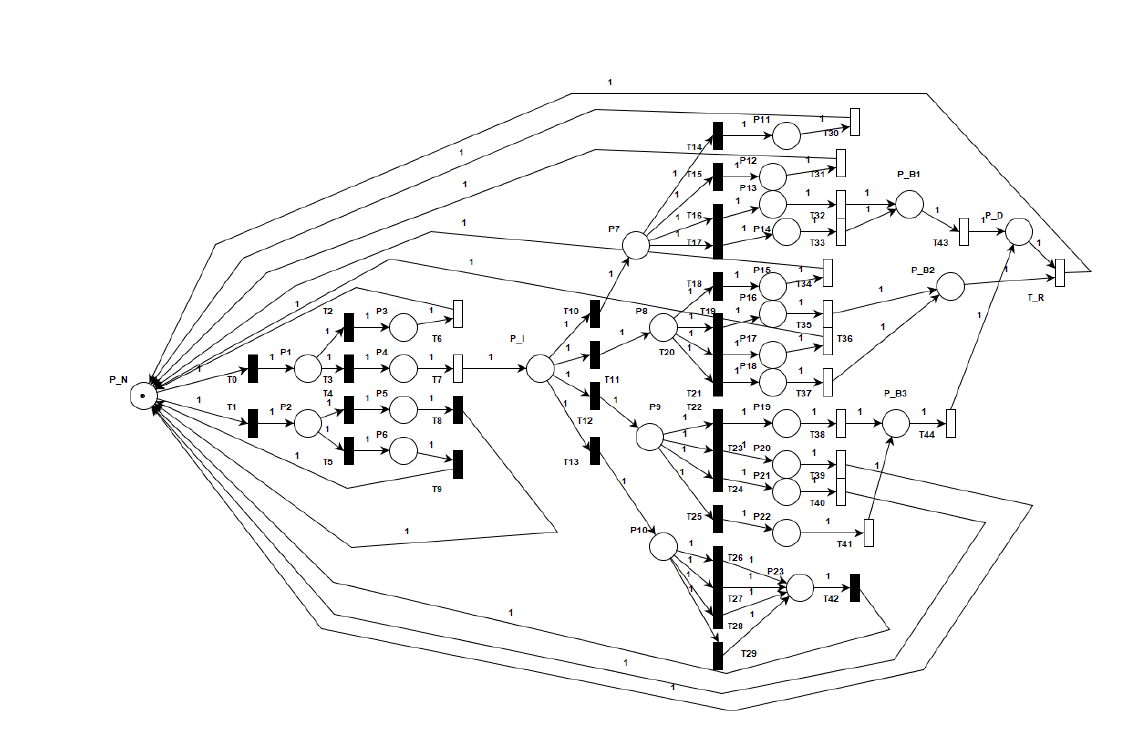
Figure 11. Attack–defense confrontation model with combined defensive